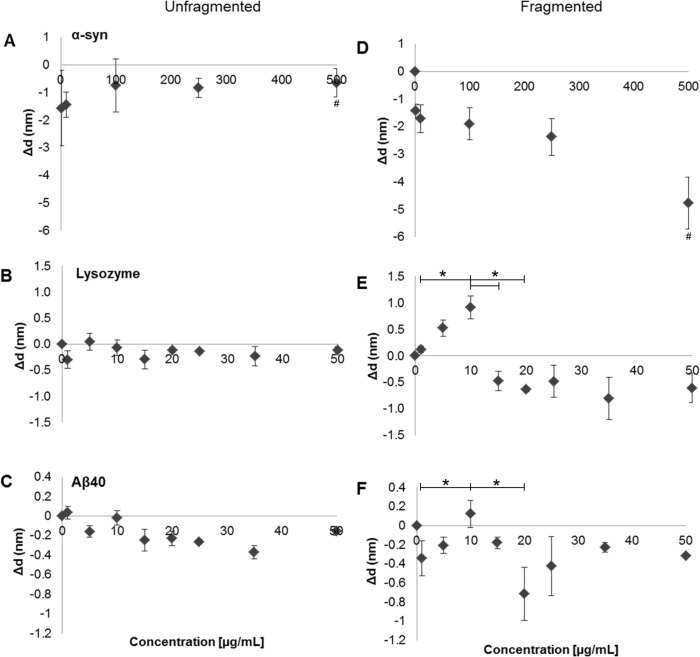
TIRE measurements of membrane disruption at native lipid membrane by the incremental addition of amyloid fibrils.Natively derived cells from the neuronal cell line; SH-SY5Y was deposited by Langmuir-Schaefer deposition and protein: lipid interactions were probed between amyloid fibril samples and plasma membranes. Left plots (A, C and E) show experiments with unfragmented samples and right plots (B, D and F) fragmented samples. Top row plots (A+D) show experiments with α-Syn, middle row (B+E) Lysozyme, and bottom row (C+F) Aβ40. Membrane thickness were measured by change in Δd (nm), which is ploted versus fibril concentration (n = 3, error bars show SE). Statistical significance for the differences in thickness within an experiment on exposure to fragmented fibril samples was determined by Kruskal Wallis test with an Conover-Inman post hoc-test. (*) or (**) denote P ≤ 0.05 and P ≤ 0.005, respectively. Statistical significance between separate unfragmented and fragmented experiments in the case of α-syn was also determined by Kruskal Wallis with an Inman post hoc-test with P ≤ 0.05 (#).